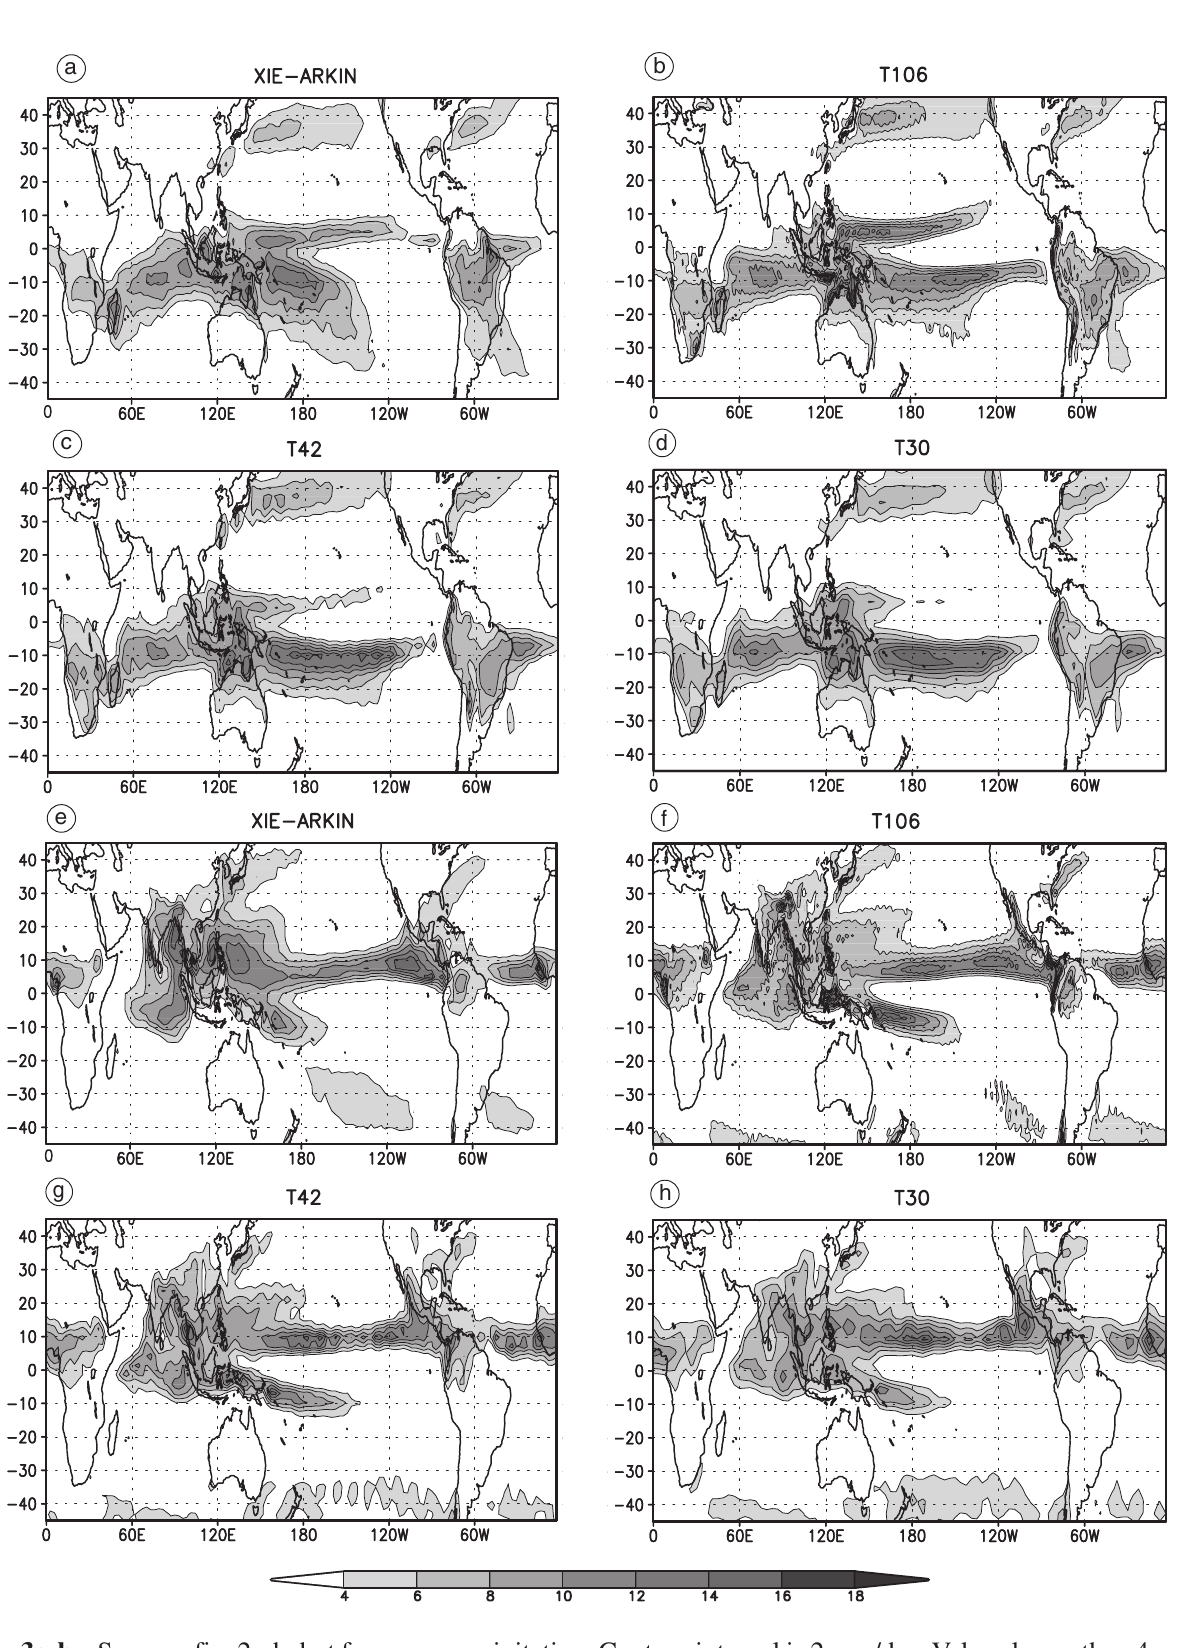
Fig. 3a-h. Same as fig. 2a-h, but for mean precipitation. Contour interval is 2 mm/day. Values larger than 4 mm/ day are